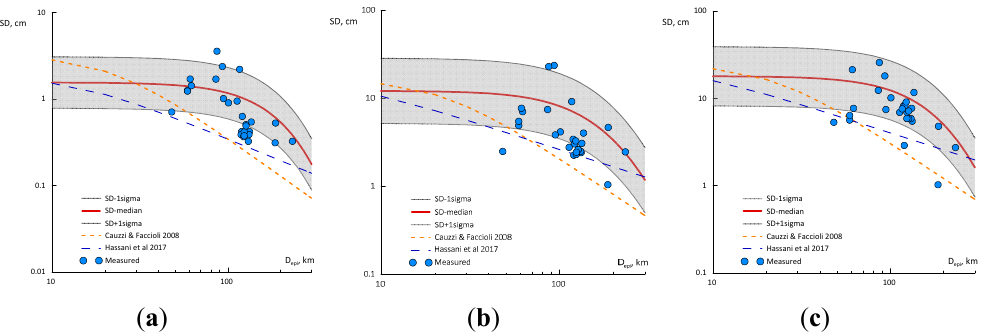
Figure 23. Attenuation of the model with distance and comparison with other models, type C soil, set 3. ( a ) T = 0.30 s; ( b ) T = 1.00 s; ( c ) T = 1.50 s. The median values for the total standard deviation are in the range 0.30–0.35 (log10 units) for type B soil, and usually smaller for type C soil. These values are smaller than the ones reported in the